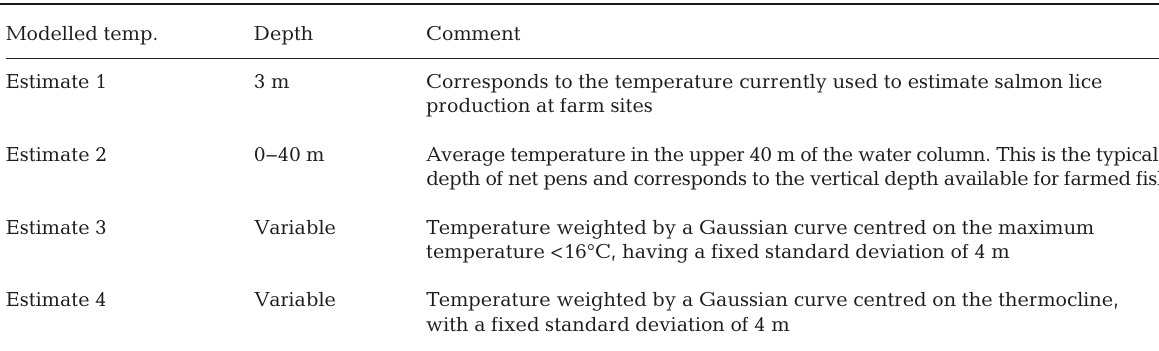
model (Table 1: fixed depth, vertical mean depth and 2 dynamic alternatives). By comparing each of the estimates to the mean value weighted by the nor- malised observed vertical distribution of the fish at Langavika, herein referred to as the fish weighted average (FWA) temperature, we evaluated how rep- resentative the estimates are in calculating the development time of salmon lice eggs on fish